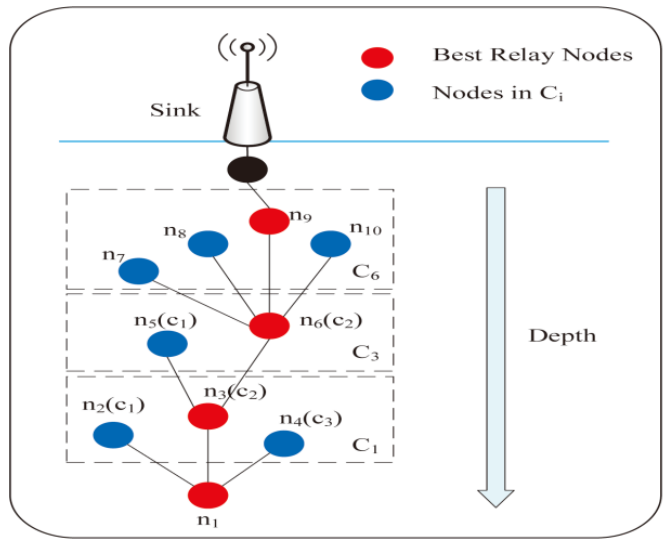
Figure 1. UWSN scenarios based on